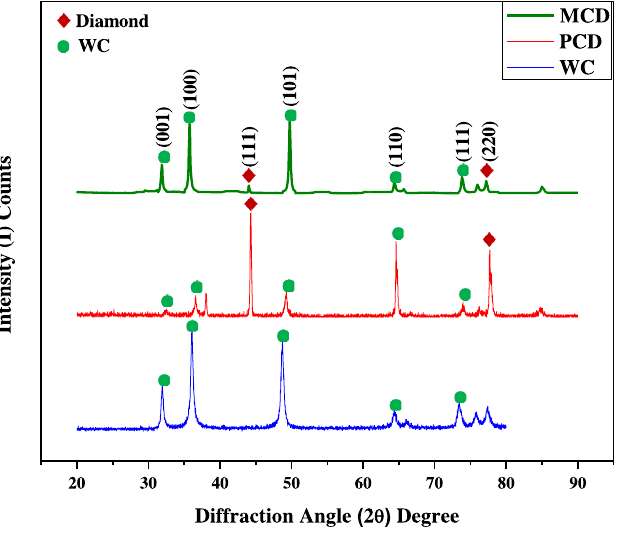
Fig. 3. XRD image of tool